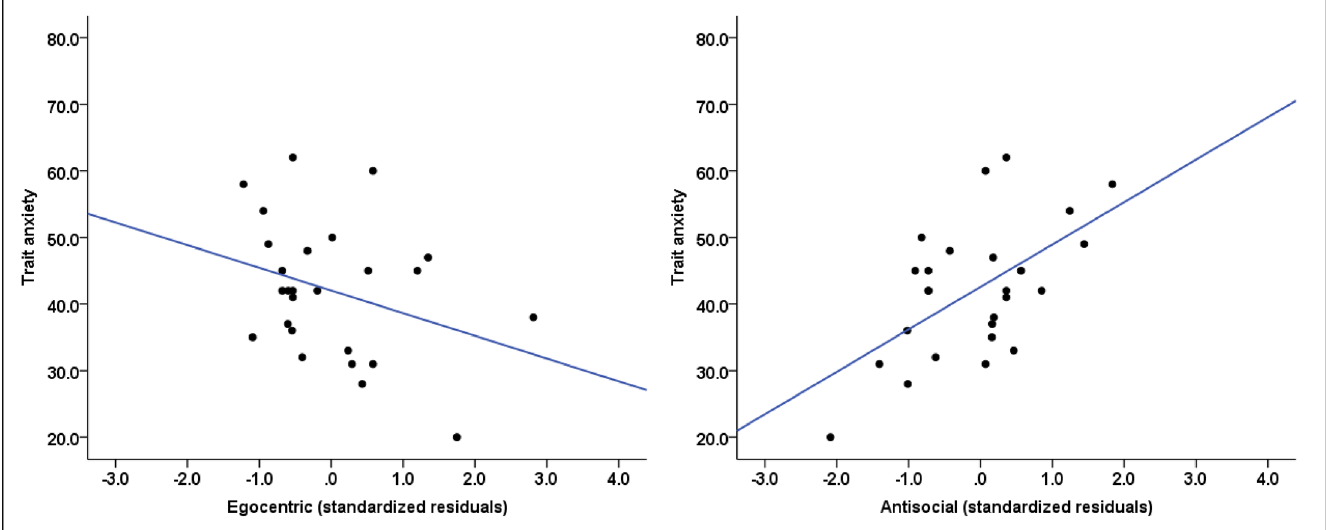
Fig 2. Scatter plots showing the relationship of (left) egocentric, and (right) antisocial psychopathic traits with trait anxiety in the violent offender sample.